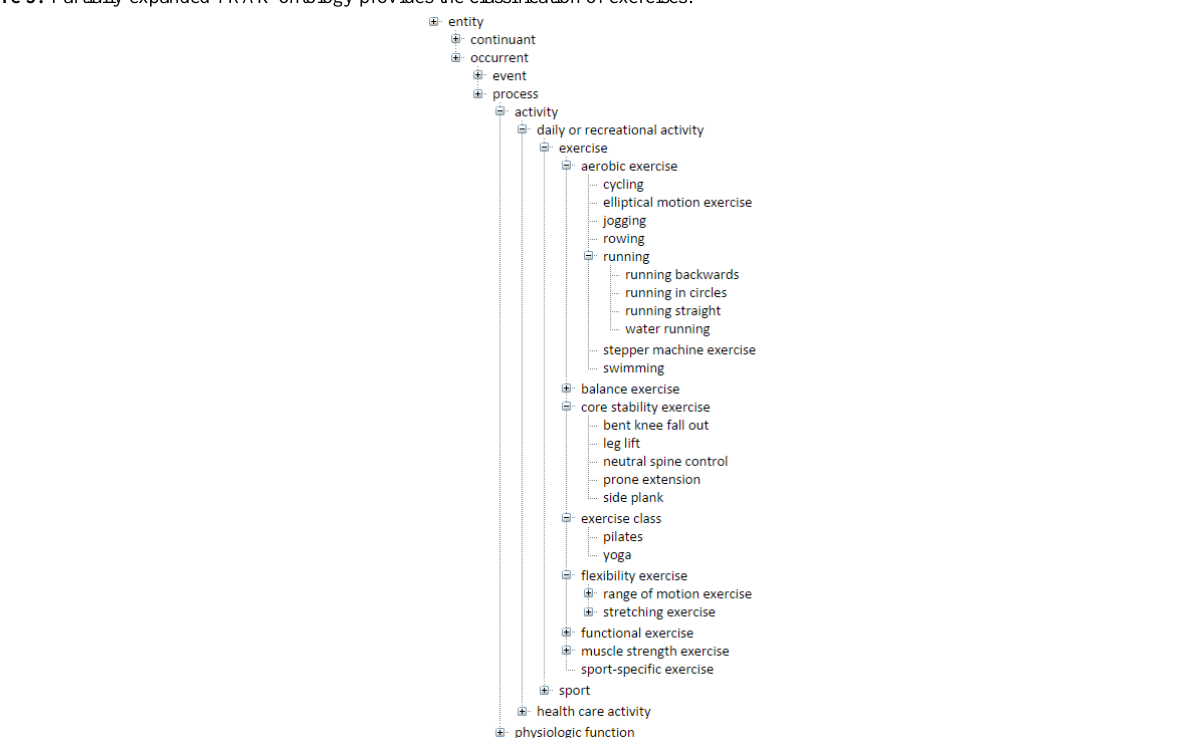
Figure 5. Partially expanded TRAK ontology provides the classification of